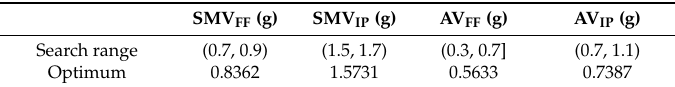
Table 2. Threshold values of Alg. 1 for the MobiAct dataset.